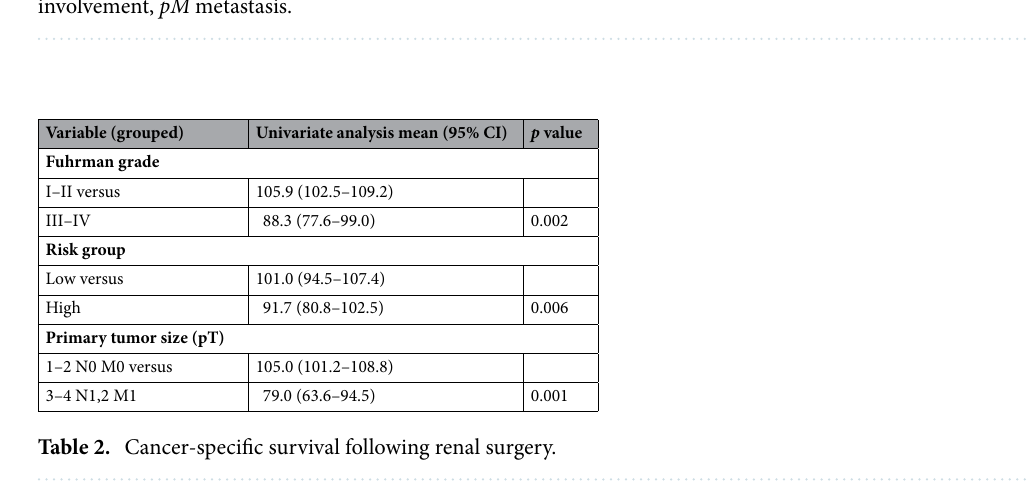
Table 1. Patients and tumor characteristics. Neph. sparing nephron-sparing surgery, pT tumor size, pN nodal involvement, pM metastasis.